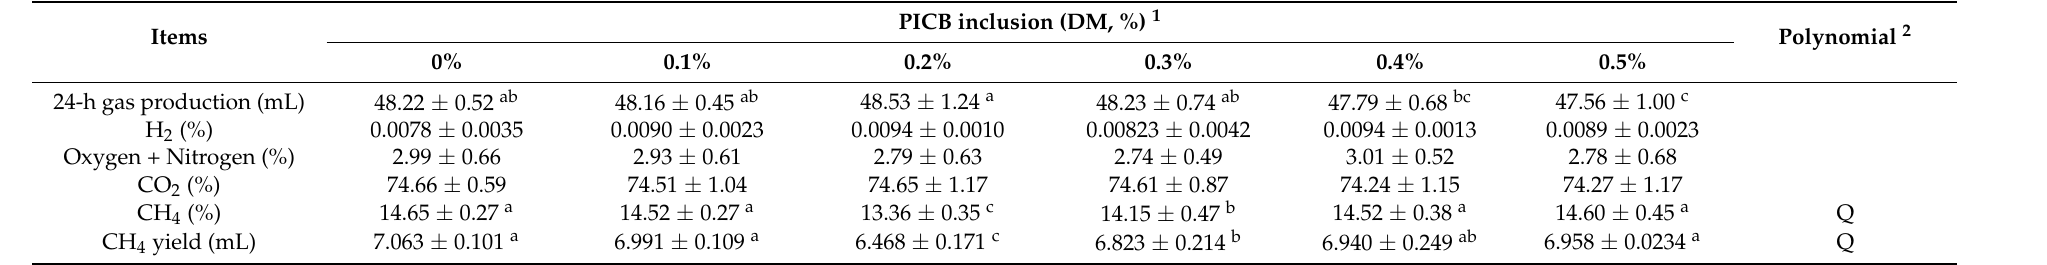
Table 3. Gas production and composition at 24-h in-vitro fermentation with different rates of PICB